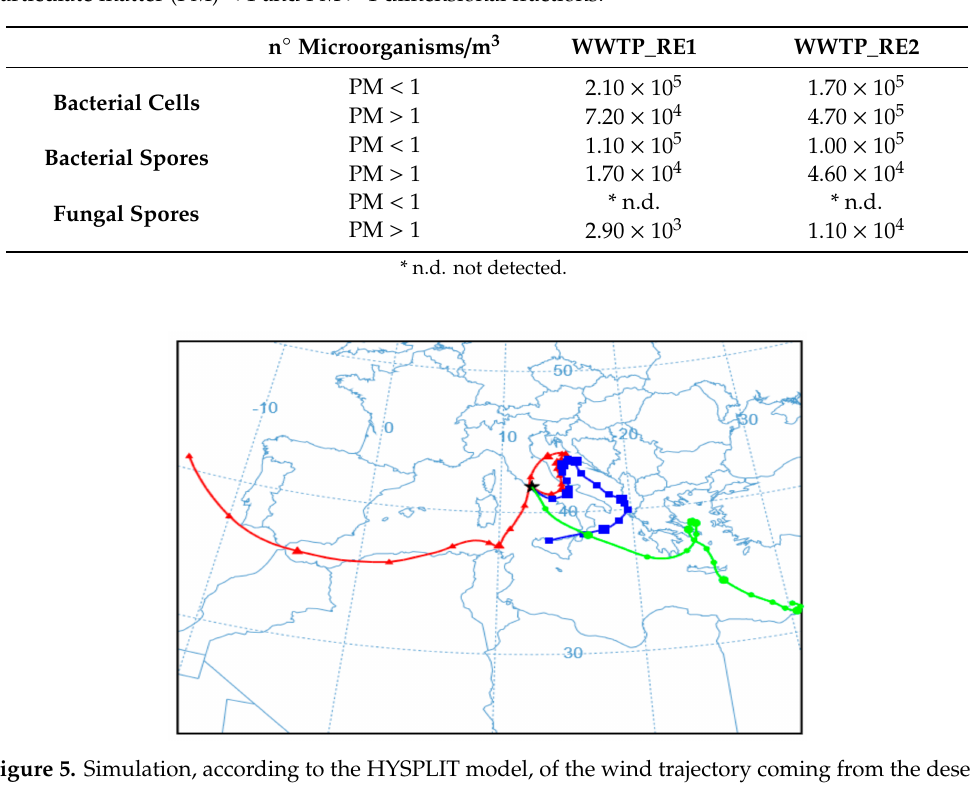
Table 4. Summary of microorganisms number / m 3 obtained during the monitoring campaign in particulate matter (PM) < 1 and PM > 1 dimensional fractions.